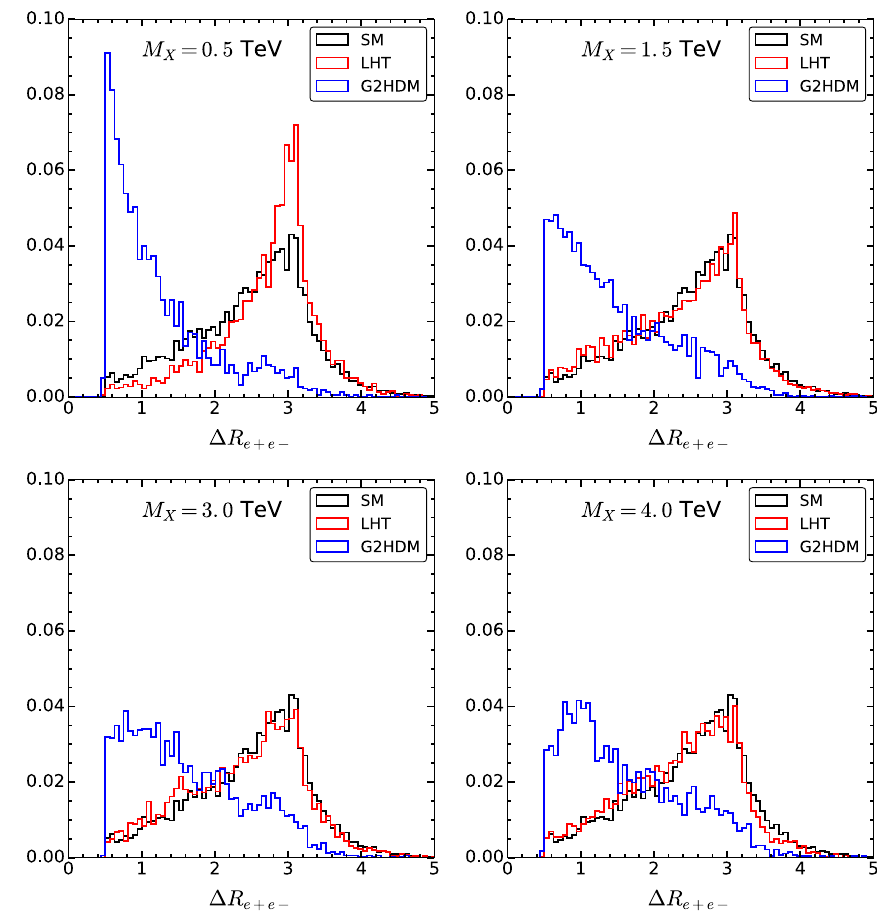
(Fig. 6) of the electron pair in the 2 l + (cid:2) E T channel, and the invariant mass M e + e − μ + μ − (Fig. 7) of four leptons in 4 l + (cid:2) E T channel. 7 The muon has the same distributions of (cid:14) R μ + μ − and M μ + μ − as the electron and will not be discussed sep- arately. For comparison, the benchmark point m X = 0 .